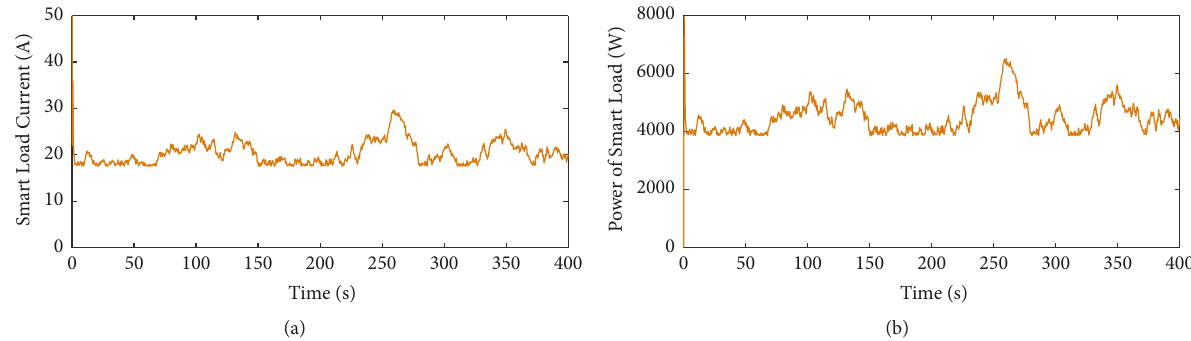
Figure 15: The current and input power waveform of smart load. (a) Smart load current. (b) The input power of smart load.